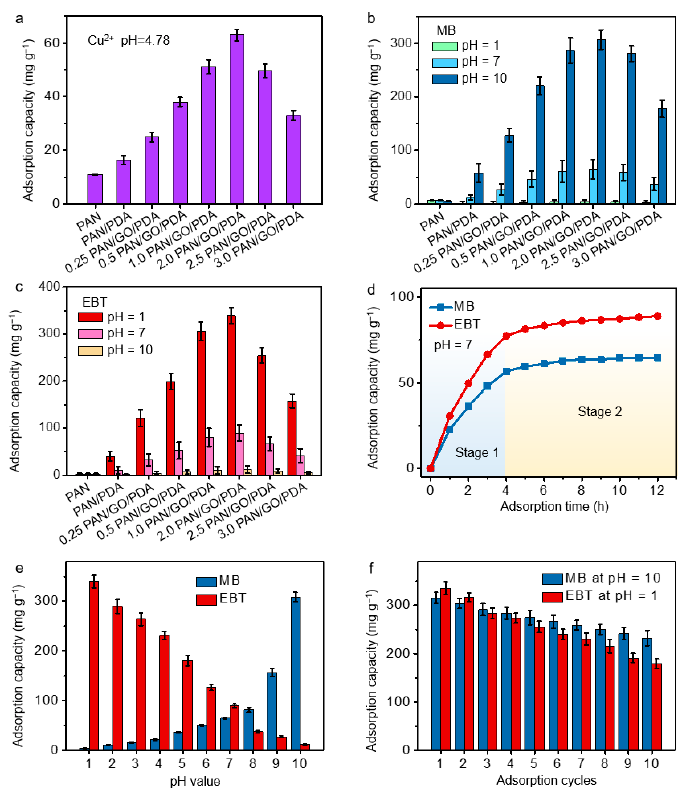
Figure 5. ( a ) Contrast of the experiments examining the membranes’ Cu 2+ ion adsorption capacities (pH = 4.78). ( b ) Contrast of the experiments examining the membranes’ MB and ( c ) EBT adsorption capacities at pH = 1, 7, and 10. ( d ) The adsorption curves of MB and EBT for 2.0 PAN/GO/PDA with change over time at pH = 7. ( e ) The pH-dependent MB and EBT adsorption performances for 2.0 PAN/GO/PDA. ( f ) The reusability tests for 2.0 PAN/GO/PDA in solutions of MB (pH = 10) and EBT (pH = 1).